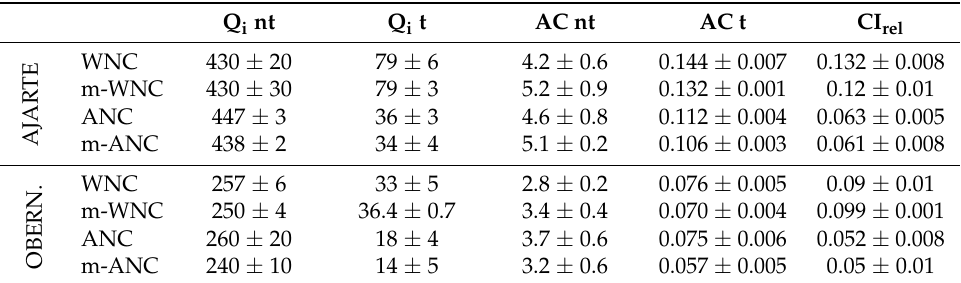
Table 7. Amount of water absorbed per unit area at 96 h (Q i , mg · cm − 2 ) and absorption rate at 30